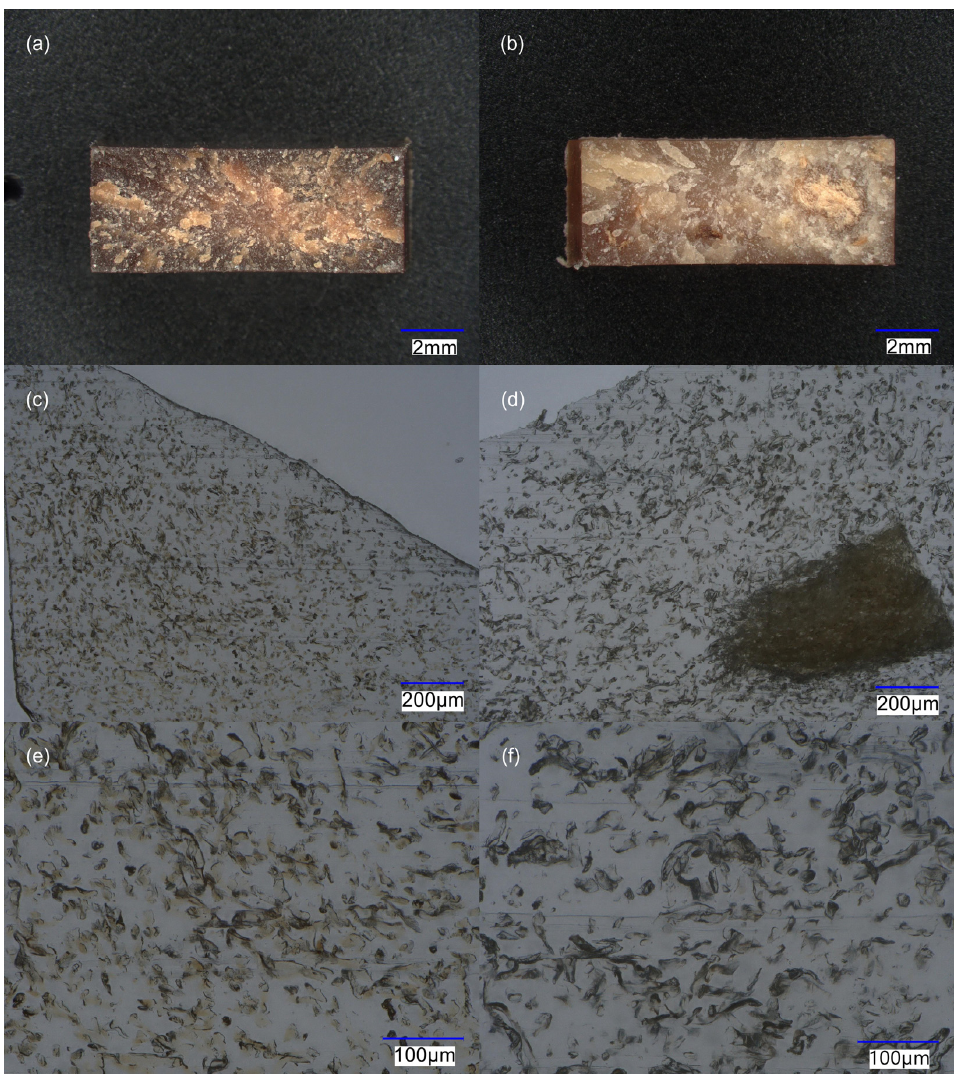
Figure 4. Optical micrographs of: ( a ) fracture surface of PA-C at 20× magnification; ( b ) fracture surface of PA-C_FDC_LT2 at 20× magnification; ( c ) microtome cut cross-section of PA-C at 300× magnification; ( d ) microtome cut cross-section of PA-C_FDC_LT2 at 300× magnification; ( e ) microtome cut cross-section of PA-C at 500× magnification; ( f ) microtome cut cross-section of PA-C_FDC_LT2 at 500× magnification.